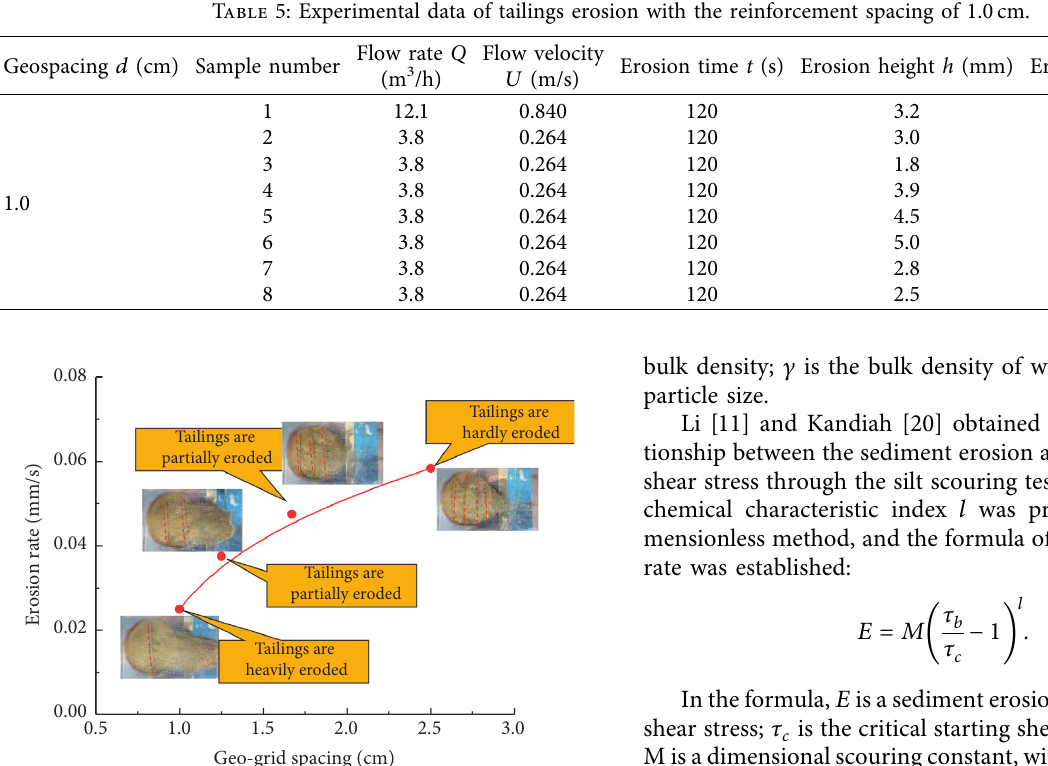
Figure 7: Relationship between erosion rate and geogrid